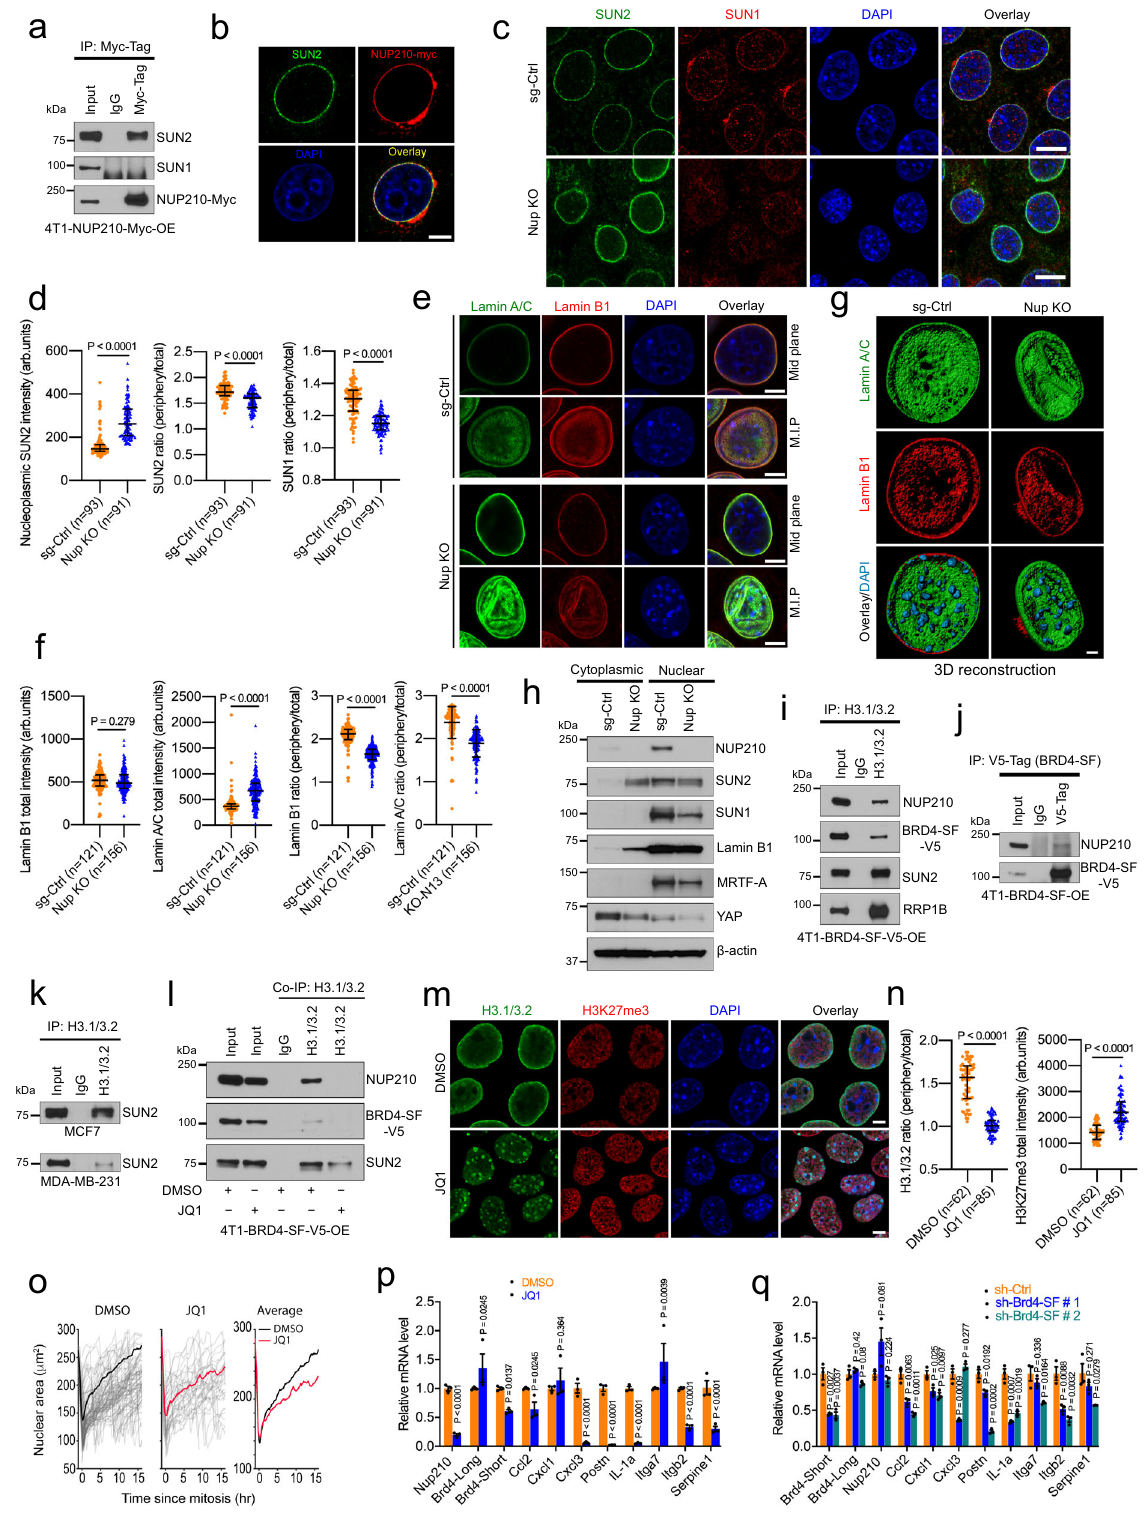
(Fig. 8i). BRD4-SF also interacts with NUP210 in these cells (Fig. 8j). H3.1/3.2 – SUN2 interaction was also evident in human breast cancer cells MCF7 and MDA-MB-231 (Fig. 8k). We then tested the necessity of either NUP210 or BRD4-SF in bridging the interaction between the LINC complex machinery and H3.1/